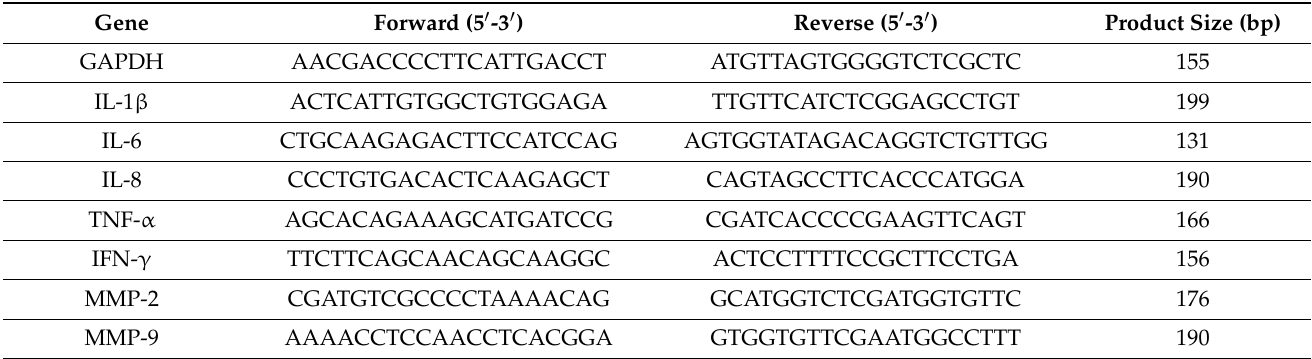
Table 1. Primers used for the quantitative PCR